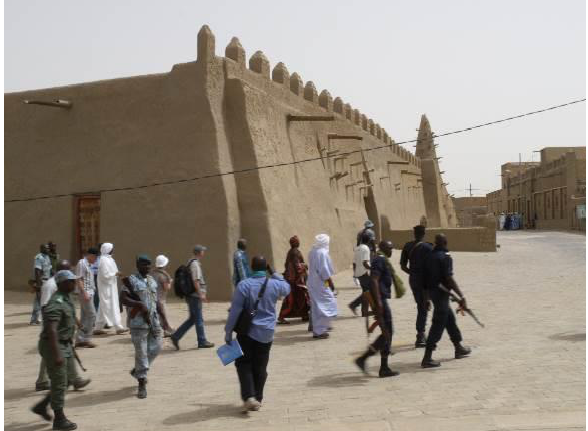
Figure 2. Inspection of Djingarey-ber mosque on June 6, 2013 © Joffroy T.